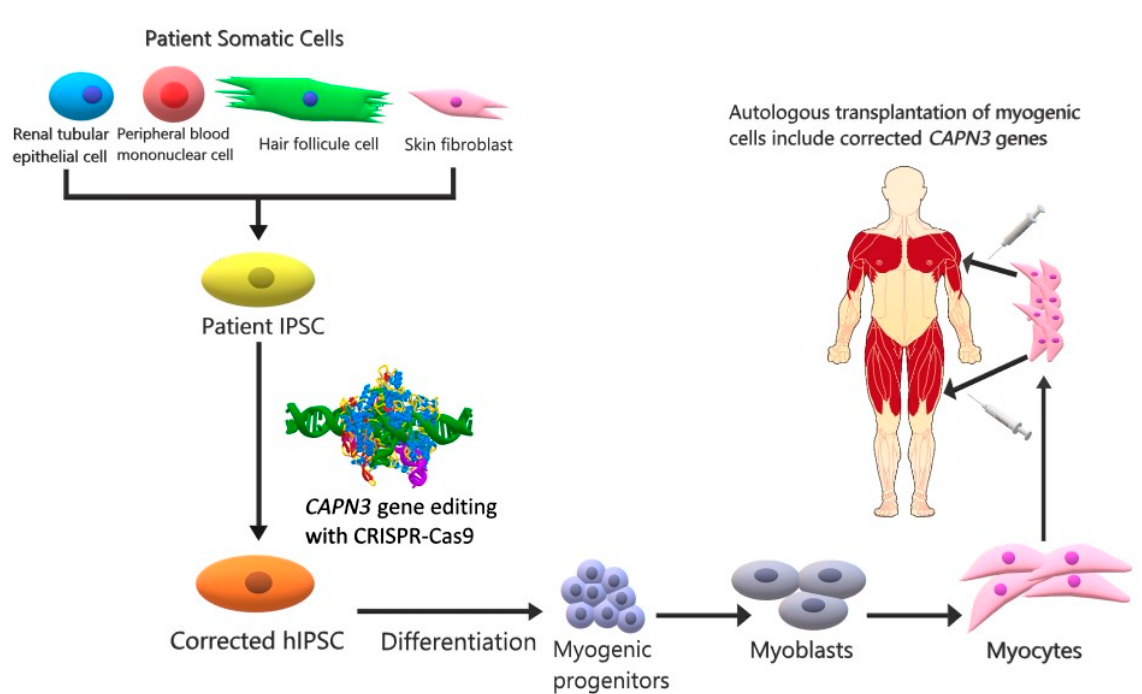
Figure 2. CAPN3 cell therapy with a combination of IPSCs and CRISPR-Cas9. In IPSCs derived from the somatic cells of the LGMDR1 patient (renal tubular epithelial cell, peripheral blood mononuclear cell, hair follicle cell, skin fibroblast) using reprogramming factors, the CAPN3 gene is corrected by means of the CRISPR-Cas9 method. Genetically modified IPS cells are then stimulated with various factors (Pax3/Pax7 or MyoD) to differentiate into myogenic progenitors that can be multiplied in number. Cellular therapy is applied to the patient by injecting the proliferated myocytes intramuscularly into the muscles [46]. Table 1. Current therapy strategies.